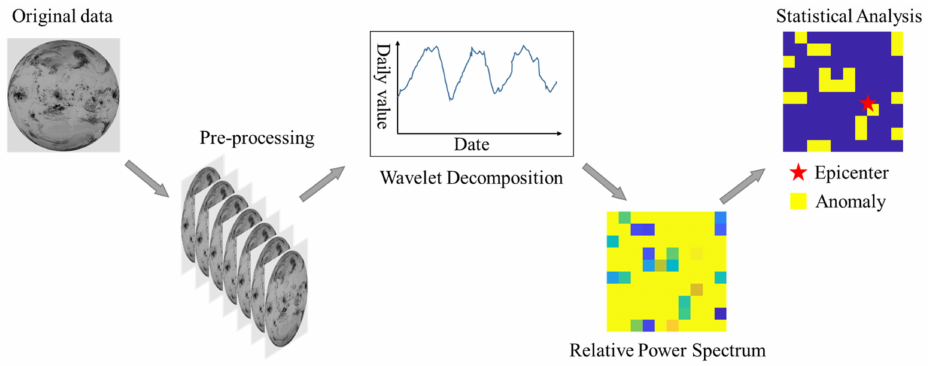
Figure 1. The flow of the research method.